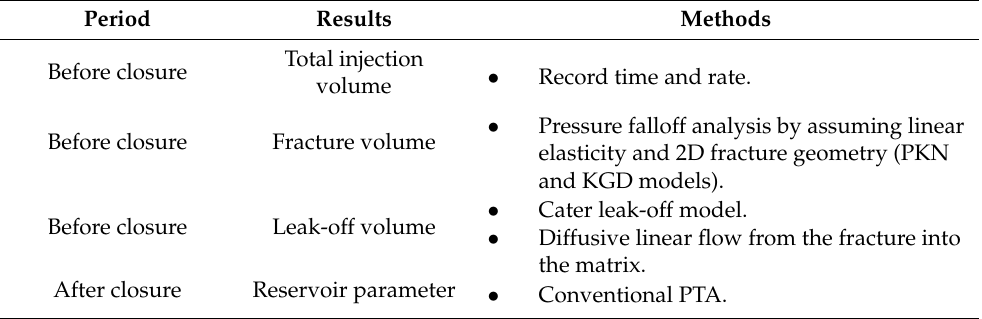
Table 4. Main results and methodologies of DFIT analysis.